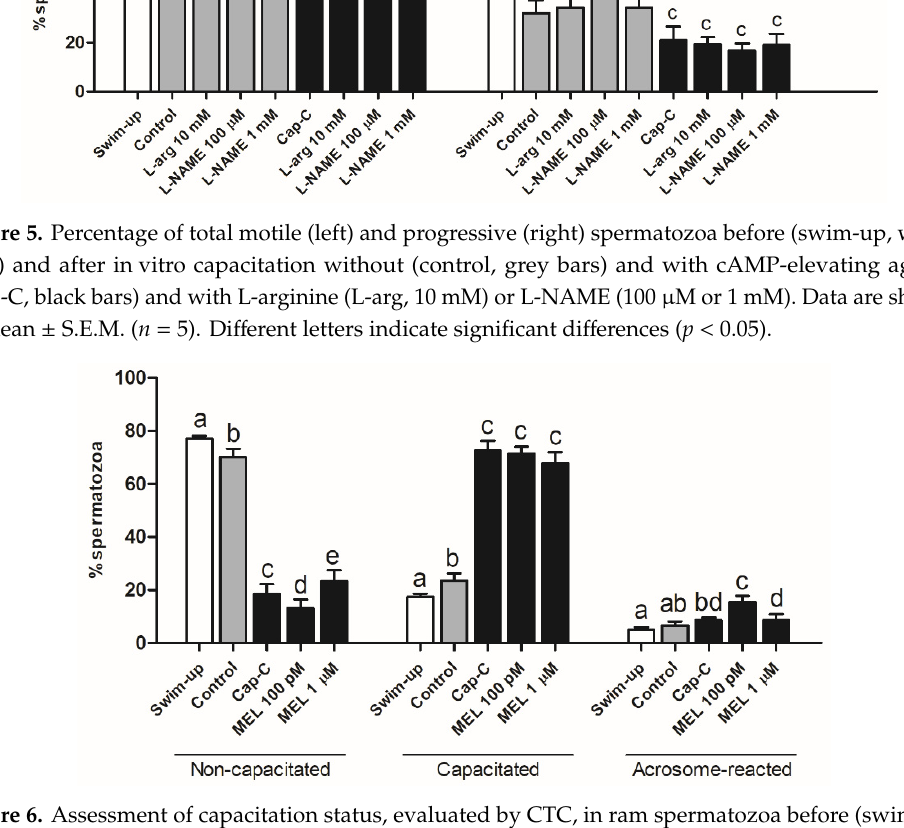
Figure 5. Percentage of total motile (left) and progressive (right) spermatozoa before (swim-up, white bars) and after in vitro capacitation without (control, grey bars) and with cAMP-elevating agents (Cap-C, black bars) and with L-arginine (L-arg, 10 mM) or L-NAME (100 µM or 1 mM). Data are shown as mean ± S.E.M. ( n = 5). Different letters indicate significant differences ( p < 0.05).